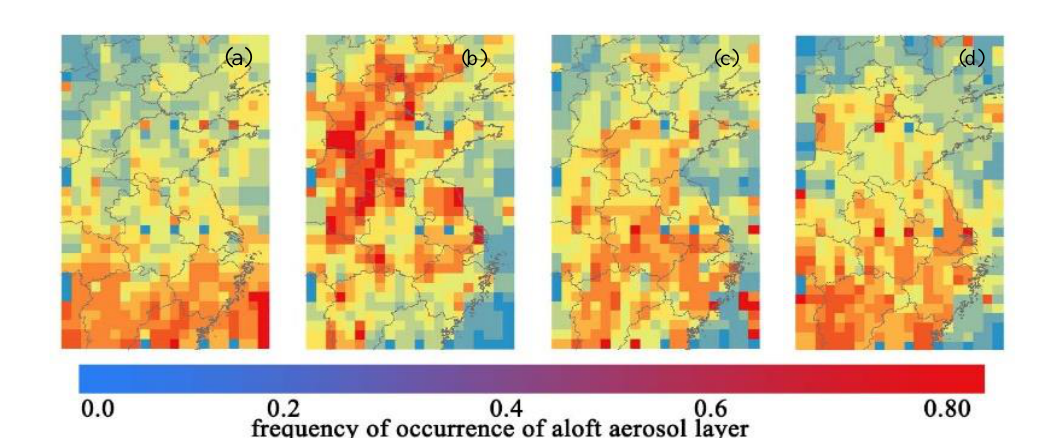
Figure 1. The spatial distribution of averaged layer top altitude of the aloft aerosol layer with a resolution of 0.25 ° for a